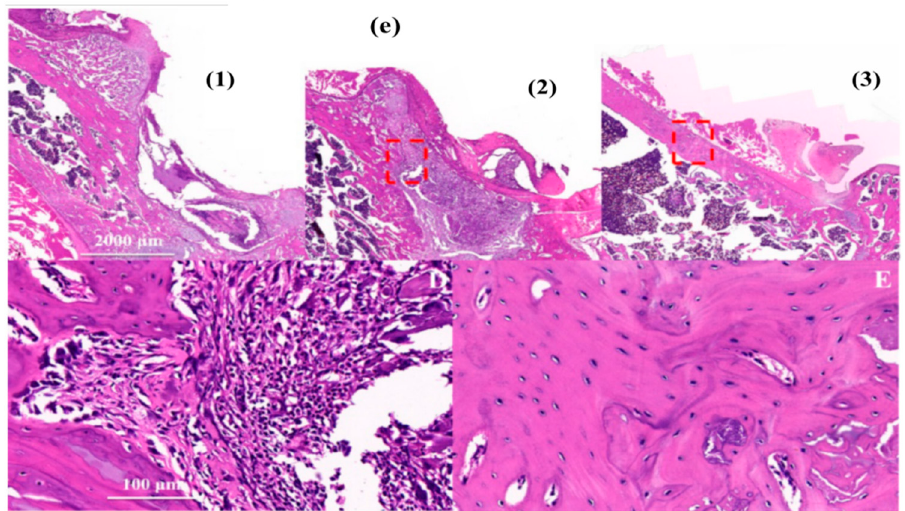
Figure 20. The synthesis route of BMSCs-laden injectable hydrogel ( a ), MSCs osteogenic differentiation within HA-CS hydrogels: The ALP activity of different groups ( b ), and the ALP staining ( c ); real-time PCR analysis: ALP, Col I, RunX2, and OCN expressions by BMSCs in the hydrogel after ( d ); incubation for 7 and 14 days; H&E staining of bone defect samples of different groups ( e ). Control group (1), control group at fourth week (2), the BMSCs-laden hydrogel encapsulated with BMP2 group at 4th week (3) (** and *** denotes to significant error) (adapted with permission from Miller et al., 2021).